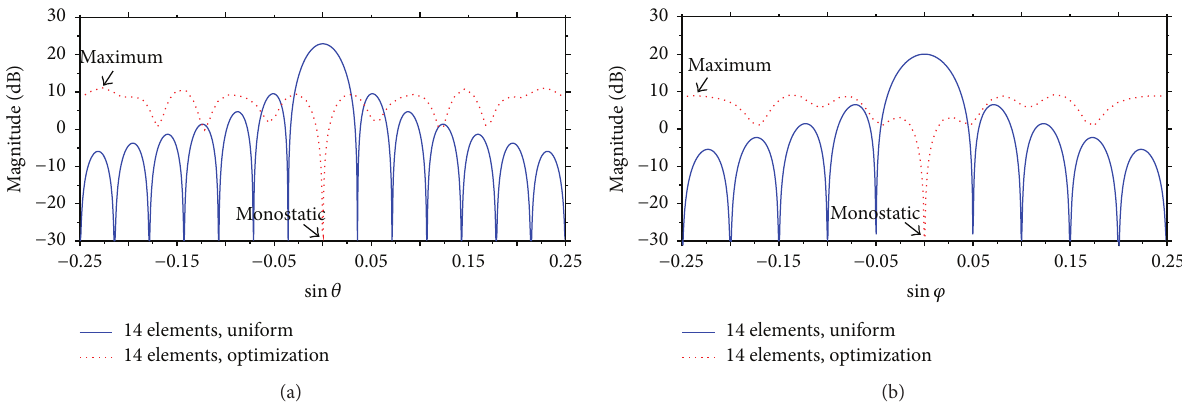
Figure 8: Far field scattering pattern along (a) horizontal direction and (b) vertical direction within the main period obtained by PSO.